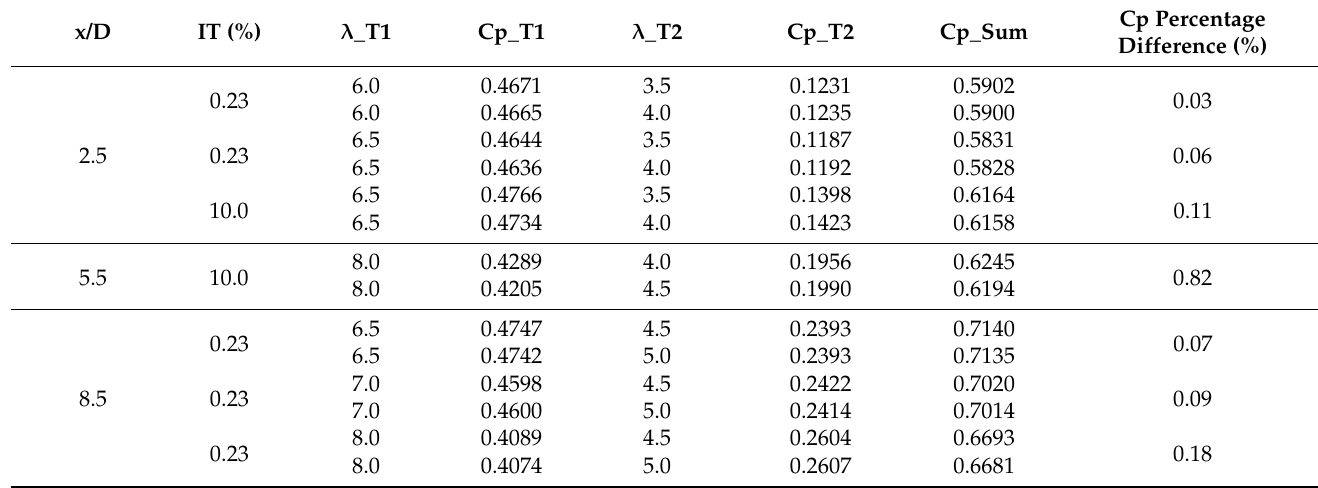
Table 1. T1 and T2 operation points at which the total Cp (Cp_Sum) is maximized.